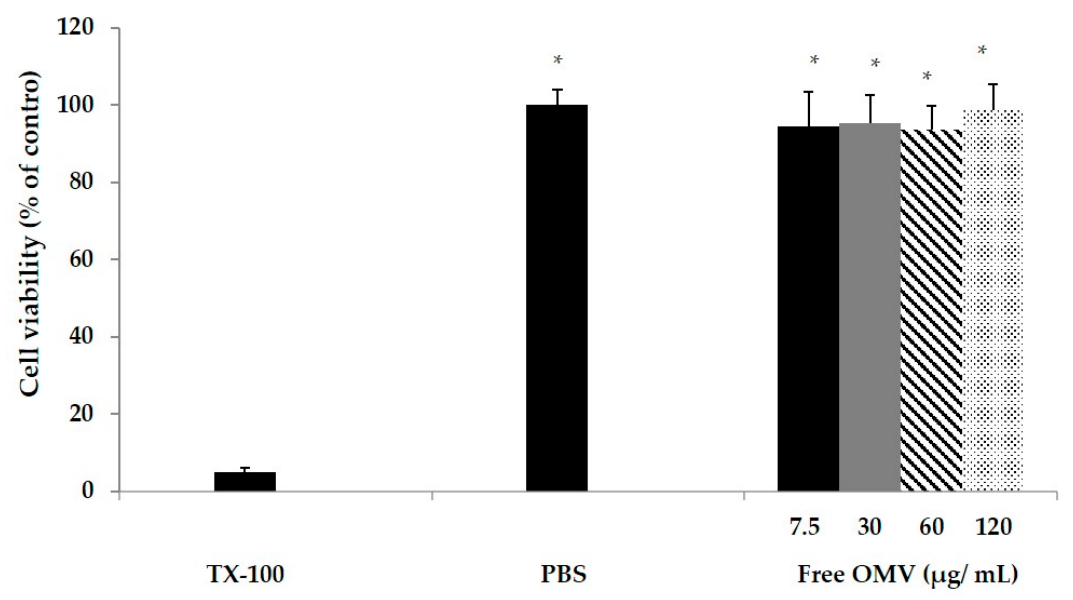
Figure 2. Effect of OMV on the mitochondrial activity (MTT assay) of RAW 264.7 macrophage cells. Figures indicate the percentage (%) of mitochondrial activity of murine macrophages RAW 264.7 after treatment for 24 h with different concentrations of OMV (µg/mL). The results are shown as the mean for triplicate assays ± SD (* p < 0.05).